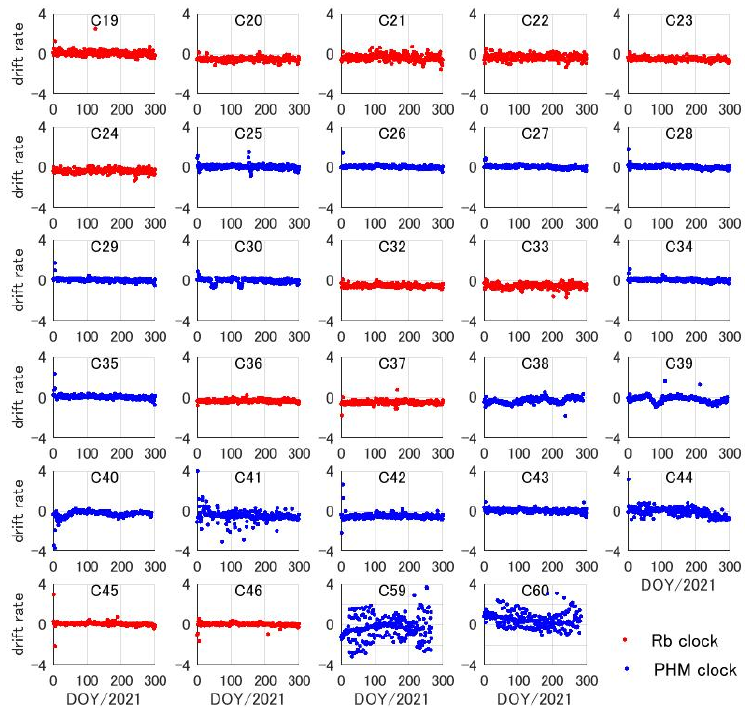
Figure 6. Drift rate series of the BDS-3 onboard clocks from DOY 1 to 300, 2021 (unit: 10 − 18 s/s 2